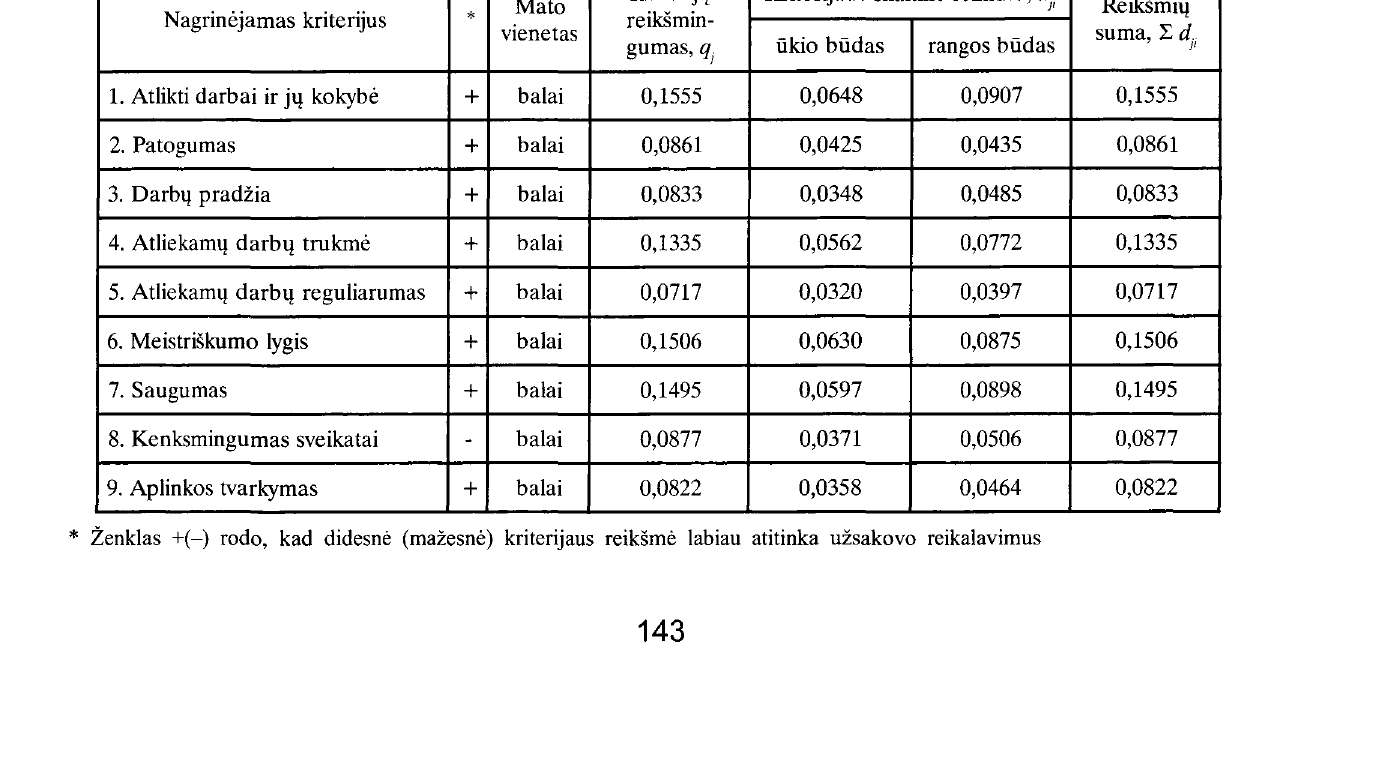
Kriterijq Kriterijaus skaitine reiksme, Mato